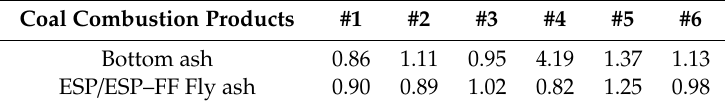
Table 4. Relative enrichment index (REI) values of Cr in ESP / ESP–FF fly ash and bottom ash of the six